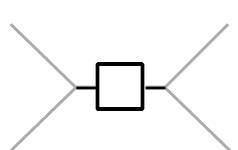
Figure 2.22: The Process Description glyph for process